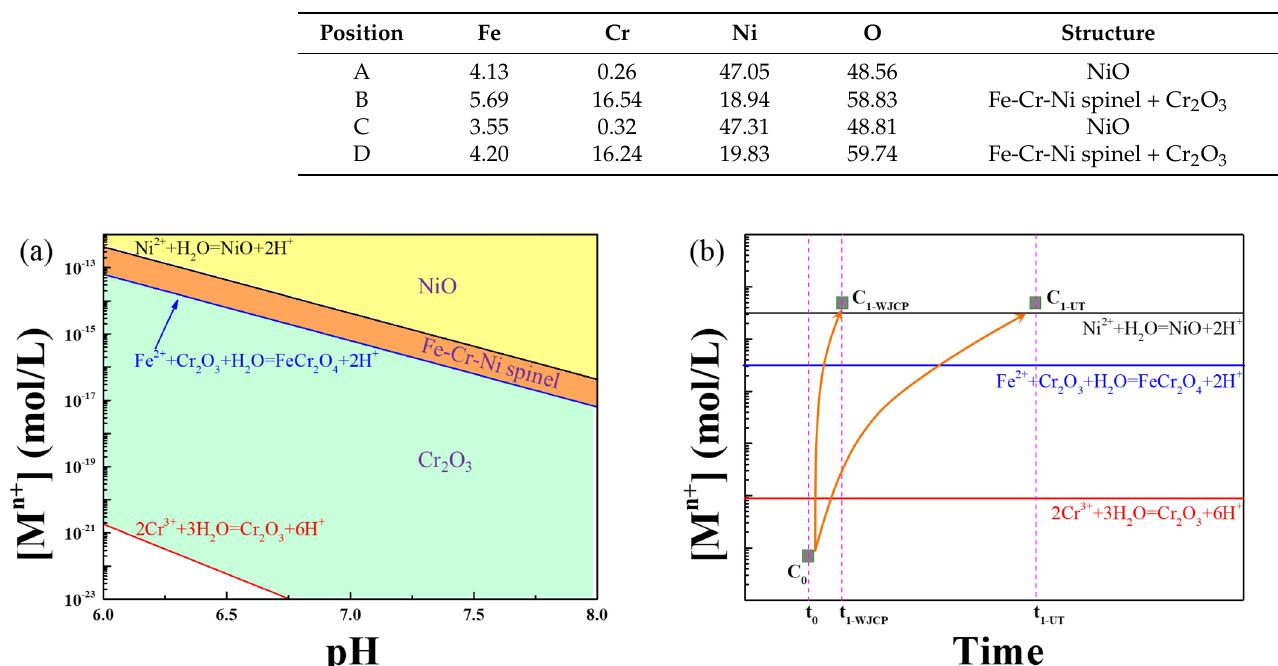
Table 3. Chemical composition (at. %) and structure of the oxide scale formed on the UT and WJCP-treated surface.